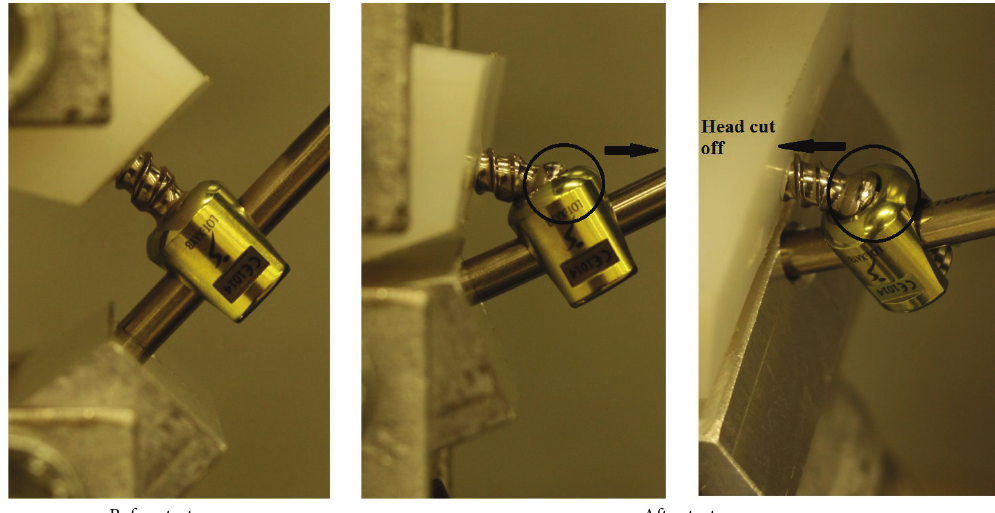
Figure 6: Flexion moment test, before and after.